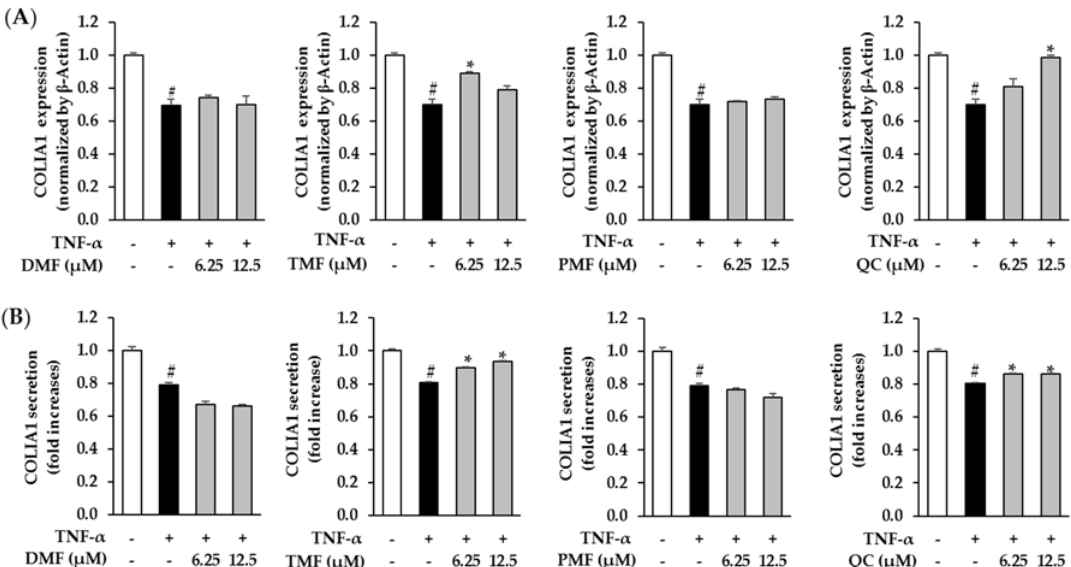
Figure 5. Effects of DMF, TMF, PMF, and QC (positive control) on COLIA1 mRNA expression ( A ) and secretion ( B ). HDFs were plated in a 48-well plate at a density of 2 × 10 4 cells/well and starved with serum-free media for 24 h. Next, the cells were treated with specific concentrations of the samples for 1 h before exposure to 20 ng/mL TNF- α for 24 h. COLIA1 mRNA was assessed using qRT-PCR analysis. COLIA1 secretion in the cell supernatants was determined using an ELISA kit. The data are presented as mean ± SEM ( n = 2). # p < 0.05 compared to non-treated group and * p < 0.05 compared to TNF- α -treated group. Abbreviations: DMF, 5,7–dimethoxyflavone; TMF, 5,7,4 (cid:48) -trimethoxyflavone; PMF, 3,5,7,3 (cid:48) ,4 (cid:48) -pentamethoxyflavone; and QC,